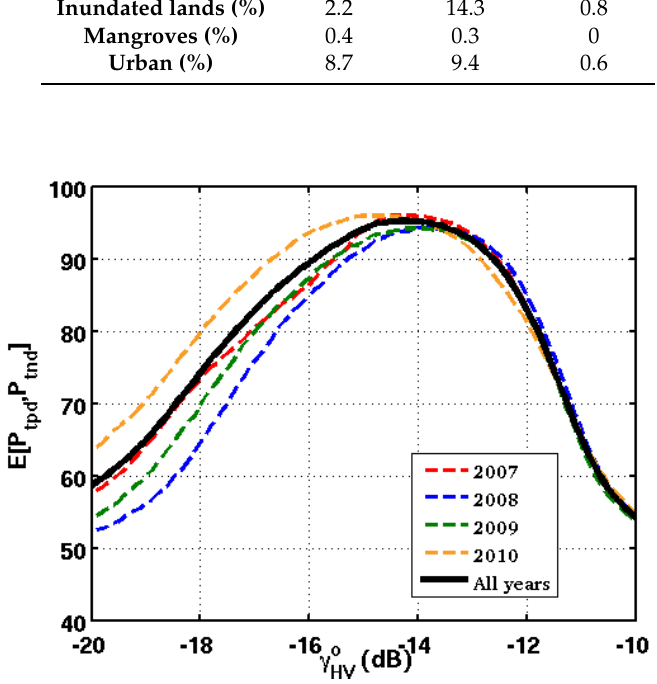
Figure 6. Average between true positive p tpd and true negative p tnd forest detection with varying thresholds applied to γ HV using ALOS PALSAR data between 2007 and 2010. The bold line represents the whole